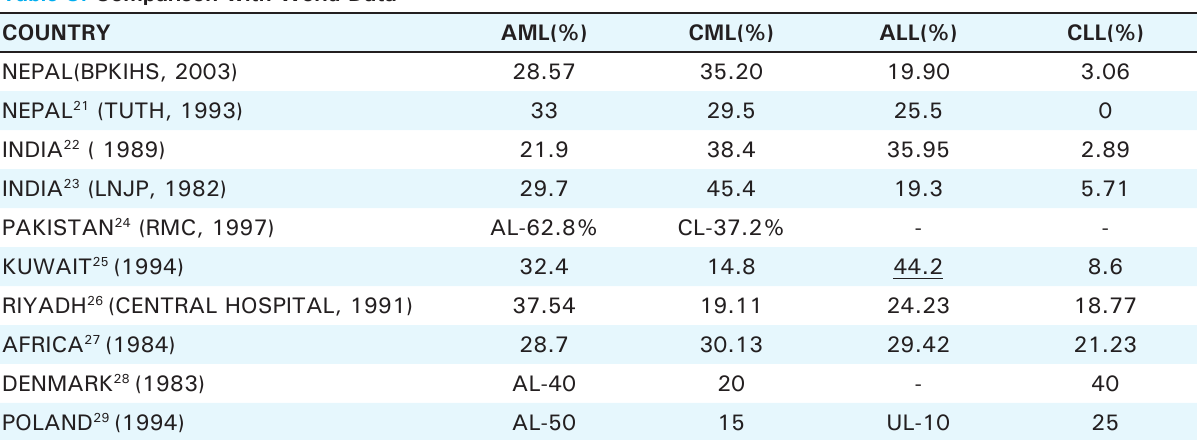
table 8. comparison with World Data